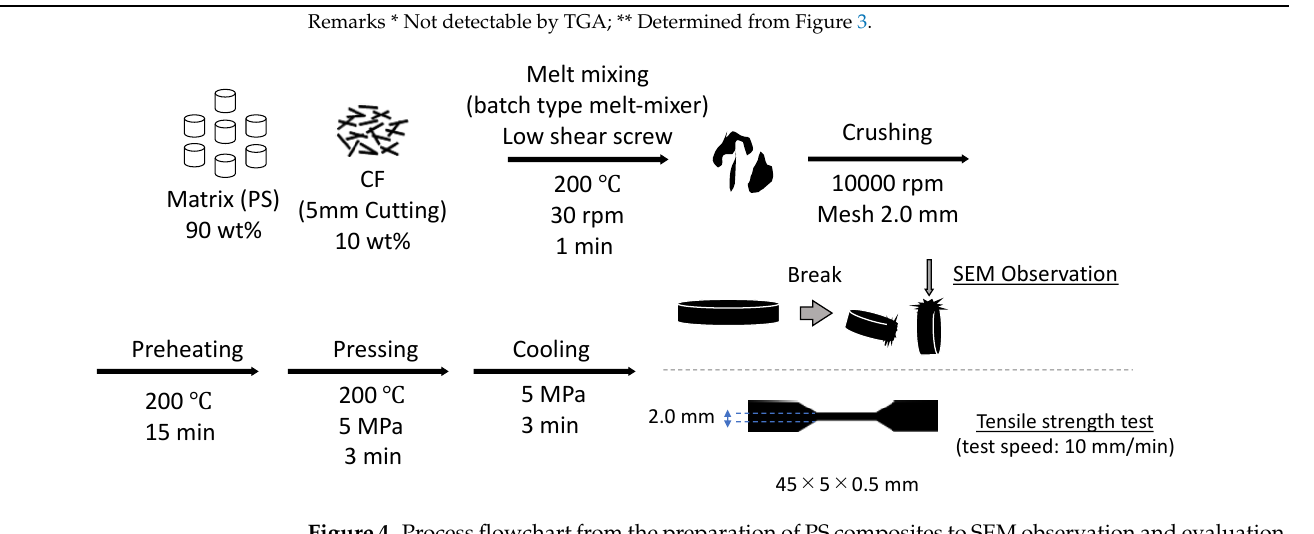
Figure 4. Process flowchart from the preparation of PS composites to SEM observation and evalua- tion.